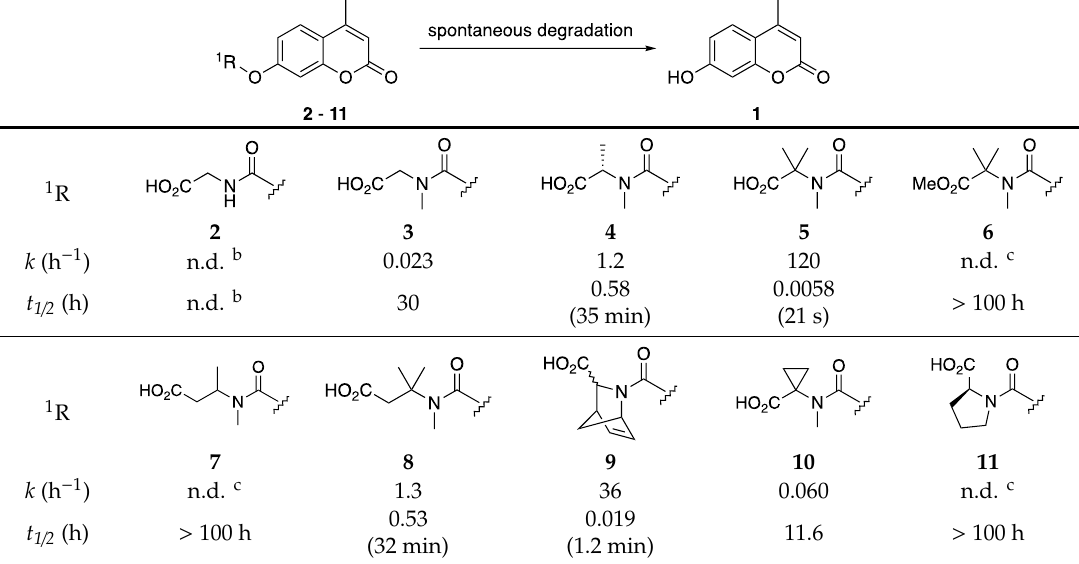
Table 1. Summary of the reaction kinetics parameters of coumarin carbamate probes bearing different linker units. a.